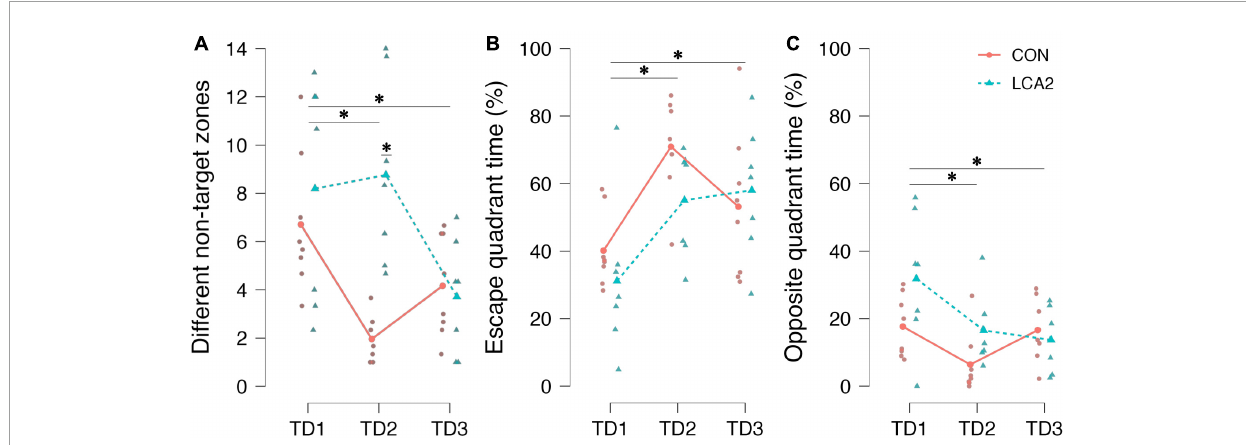
FIGURE7 (A) The number of visits to different entry zones not containing the escape box. TD1 was different from TD2 and TD3. On TD2, a statistically significant difference was found between the groups. CON = 6.7 [95% CI (4.7, 8.7)], LCA2 = 8.2 [95% CI (4.7, 11.7)], TD2: CON = 2.0 [95% CI (1.3, 2.6)], LCA2 = 8.8 [95% CI (5.9, 11.6)], TD3: CON = 4.2 [95% CI (2.7, 5.6)], LCA2 = 3.7 [95% CI (2.0, 5.4)]. (B) The time spent in the quadrant of the arena containing the escape box relative to the total time spent. A statistically significant difference was observed between TD1 and both TD2 and TD3. TD1: CON = 40% [95% CI (32, 48)], LCA2 = 31% [95% CI (14, 48)], TD2: CON = 71% [95% CI (61, 81)], LCA2 = 55% [95% CI (43, 67)], TD3: CON = 53% [95% CI (38, 68)], LCA2 = 58% [95% CI (44, 72)]. (C) The time spent in the quadrant of the arena opposite to the escape quadrant relative to the total time spent in the arena. A statistically significant difference between TD1 and both TD2 and TD3 was revealed by the post-hoc test. A statistically significant interaction was also found in the opposite quadrant. TD1: CON = 18% [95% CI (11, 24)], LCA2 = 32% [95% CI (17, 46)], TD2: CON = 6% [95% CI (0, 13)], LCA2 = 17% [95% CI (9, 24)], TD3: CON = 17% [95% CI (10, 23)], LCA2 = 14% [95% CI (7, 21)]. ∗ p <